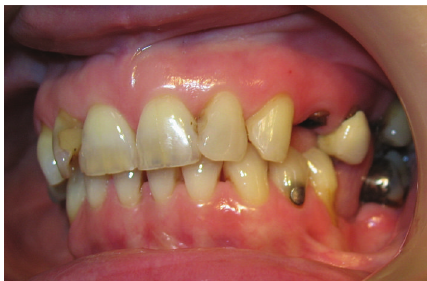
Figure 5: After removal of J